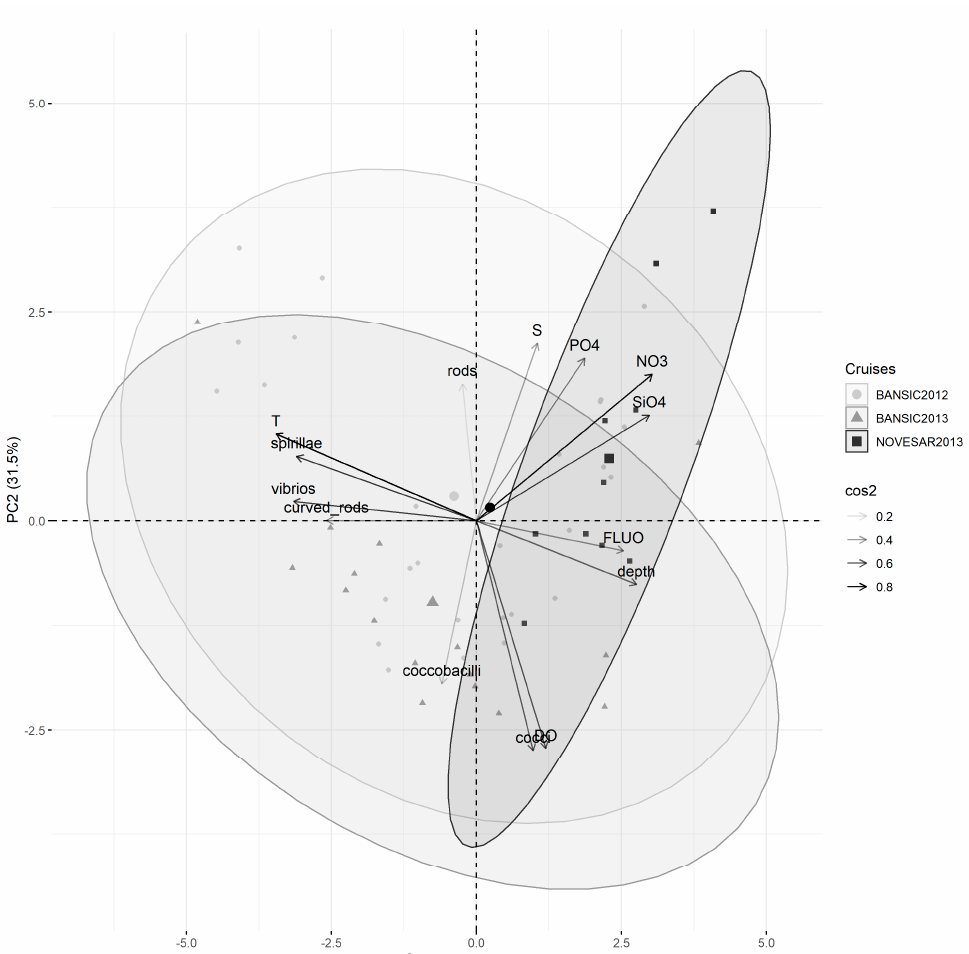
Figure 5. PCA ordination biplots for the morphotypes data and environmental variables analyzed in BANSIC 2012, NOVESAR 2013 and BANSIC 2013. The percentage of variance explained by each component is given between brackets. Arrows represent the variables included in the analyses. cos2 represents the squared loadings for variables and shows the importance of a principal component for a given observation. Filled circles represent samples collected from BANSIC 2012 cruises; filled triangles represent samples collected from BANSIC 2013 cruises; filled squares represent samples collected from NOVESAR 2013 cruises.